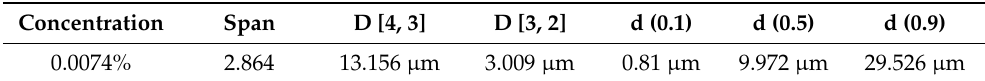
Figure 3. Particle size distribution of tricalcium silicate powder.